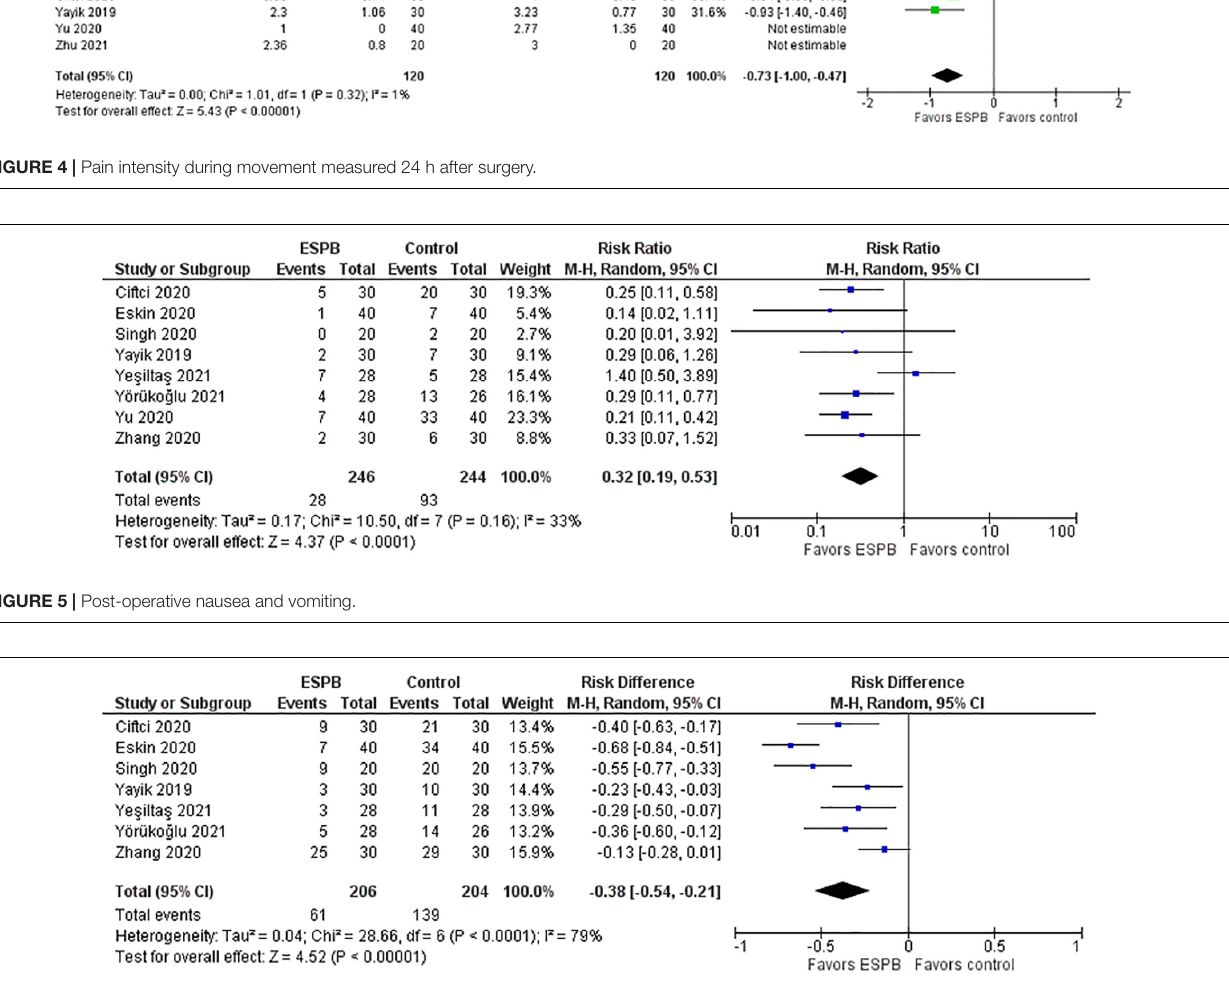
FIGURE 6 | The number of patients requiring rescue analgesia after surgery.